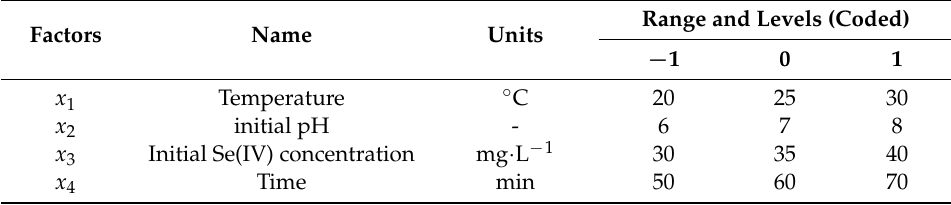
Table 1. The experimental factors and levels for the Box–Behnken